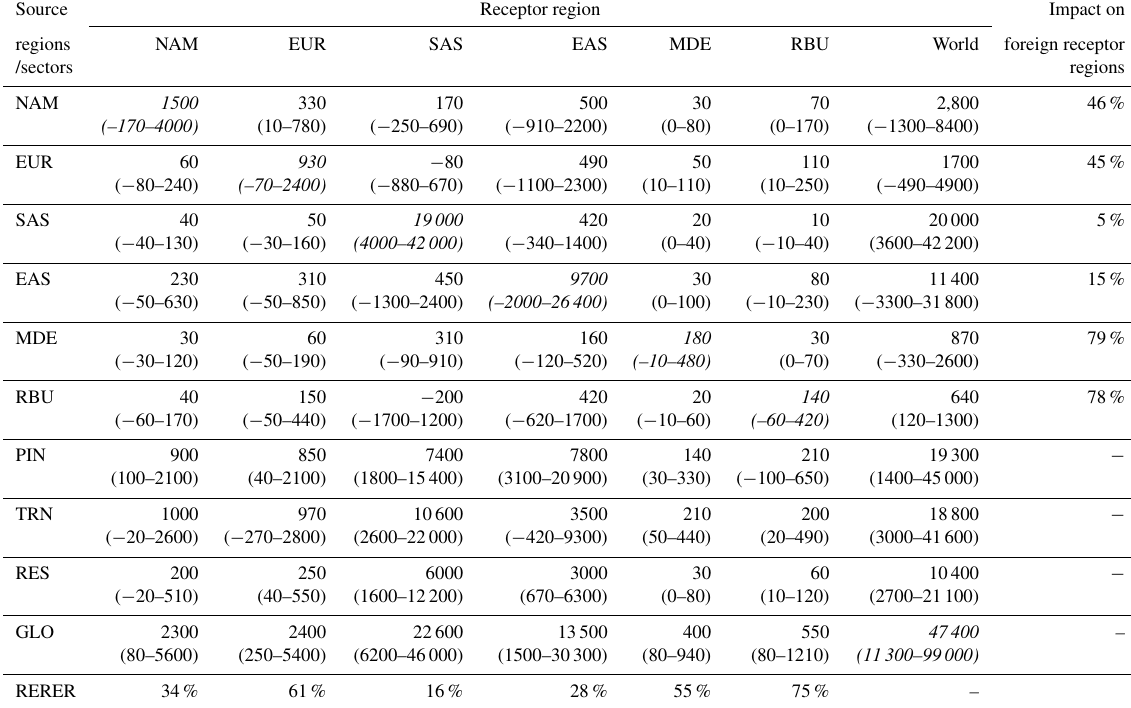
Table 5. Annual avoided multi-model empirical mean O 3 -related premature respiratory deaths with 95% CI from Monte Carlo simulations in parentheses due to 20% regional (NAM, EUR, SAS, MDE, and RBU), sectoral (PIN, TRN, and RES), and global (GLO) anthropogenic emission reductions in each region and worldwide. The diagonal, showing the effect of each region on itself, is shown in italics. For regional reductions, we also use the RERER (Eq. 4) as the percent of total avoided deaths in each receptor region that result from foreign emission reductions, as well as the percent of global avoided deaths from emission reductions in each source region. All numbers are rounded to three significant figures or the nearest 10